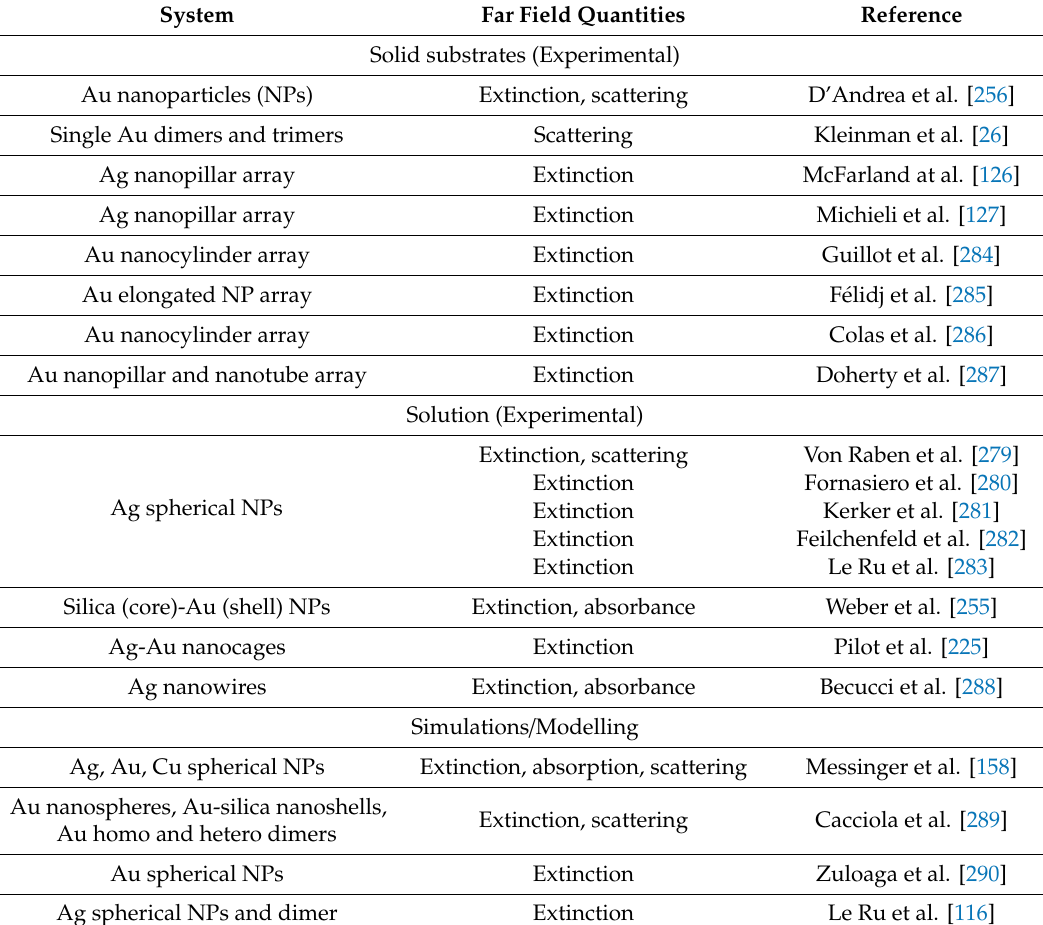
Table 4. Selection of literature papers that provide a comparison between the local field and the far field dispersion in plasmonic systems. Papers indicated as “Experimental” can contain also plasmonic simulations, while papers indicated as “Simulations / Modelling” are purely